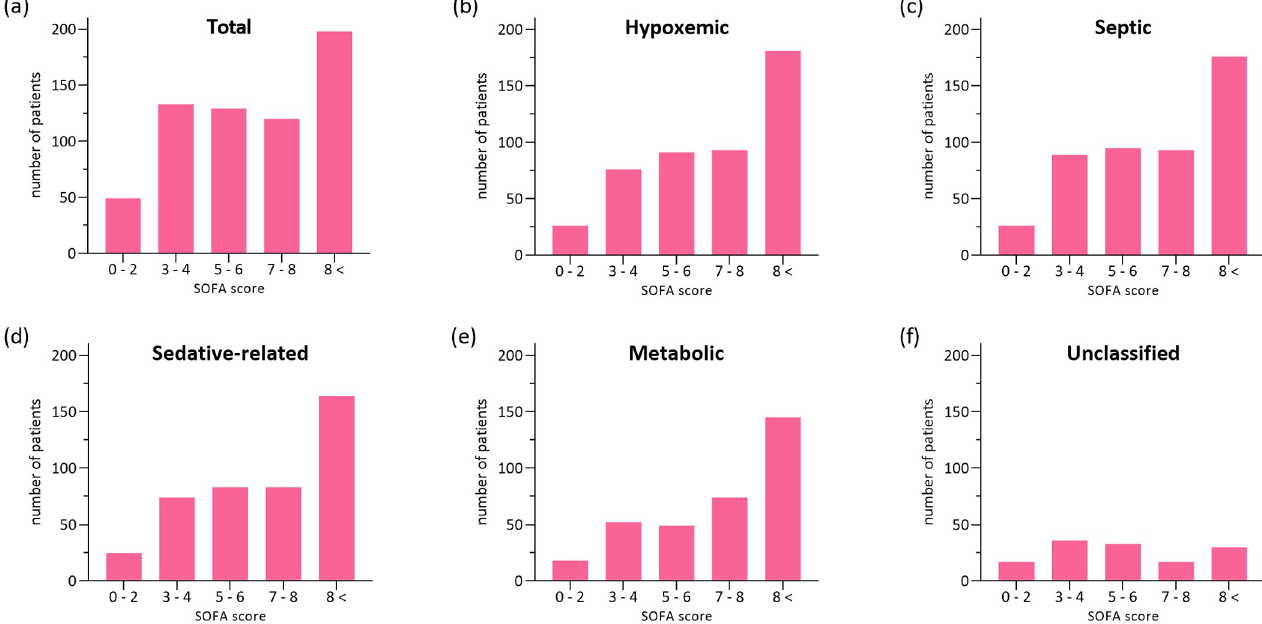
Fig 3. Prevalence of delirium phenotypes according to SOFA score. (A) Total delirium (B) Hypoxemic delirium, (C) Septic delirium, (D) Sedative-related delirium, (E) Metabolic delirium, (F) Unclassified delirium. Number of patients by the SOFA score at CICU admission were presented as bar graphs according to delirium